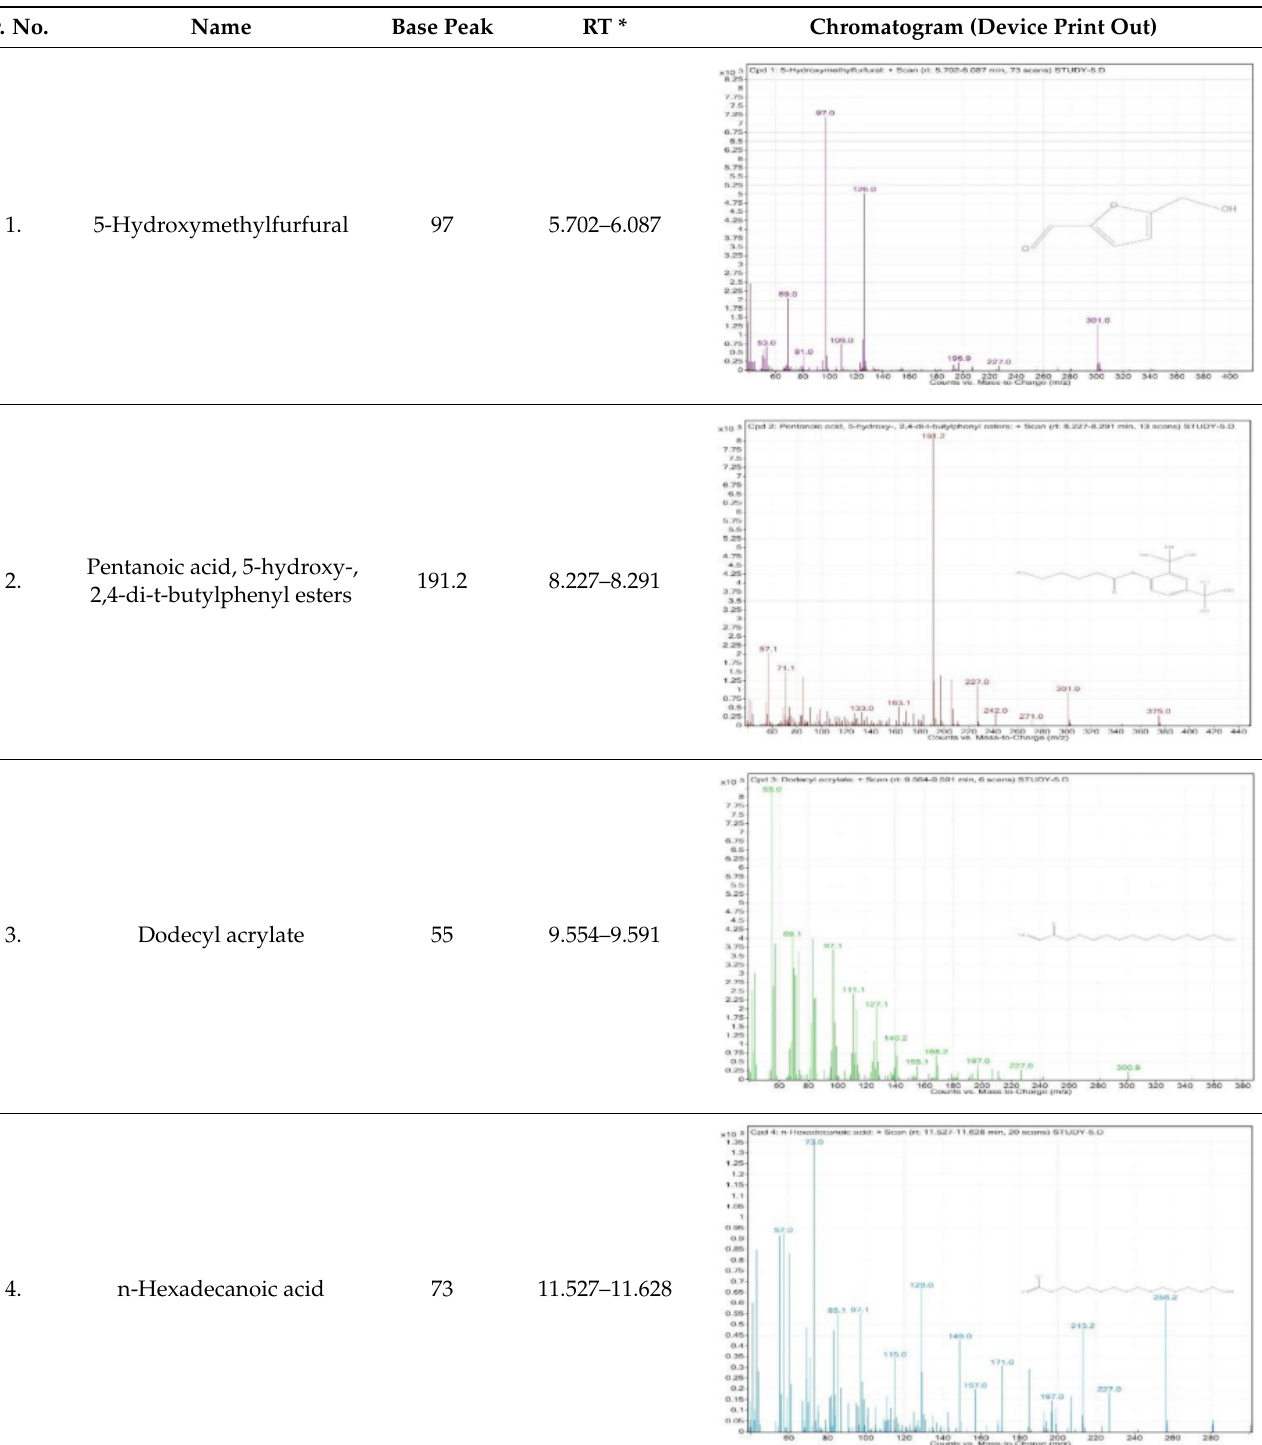
Table 2. Gas chromatography–mass spectrometry analysis of PSOE (pomegranate ( Punica granatum ) seed oil